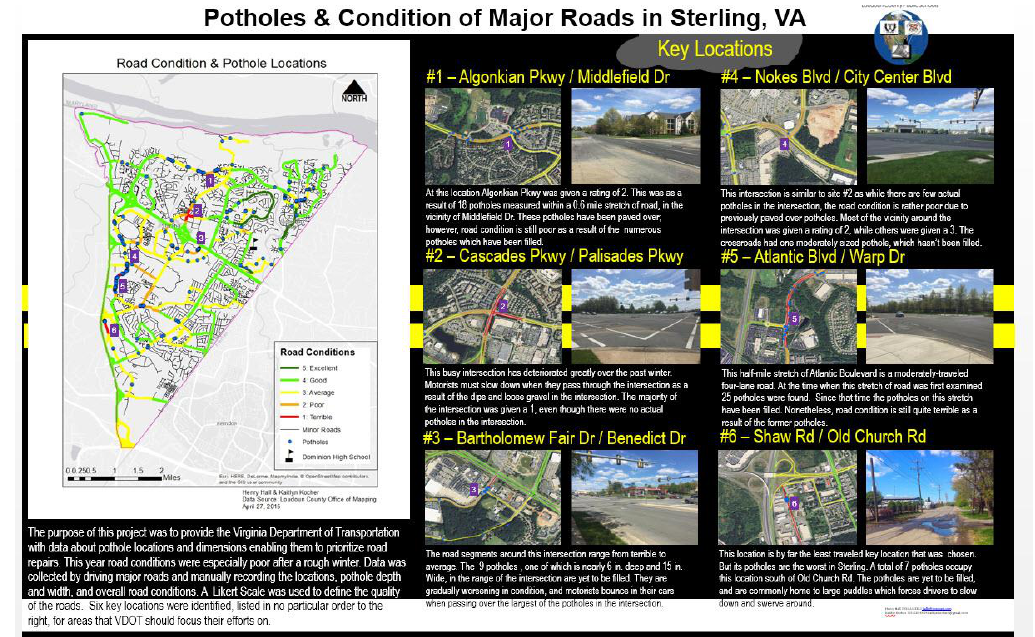
Figure 1. Student project with hand-entered GPS points and attributes.